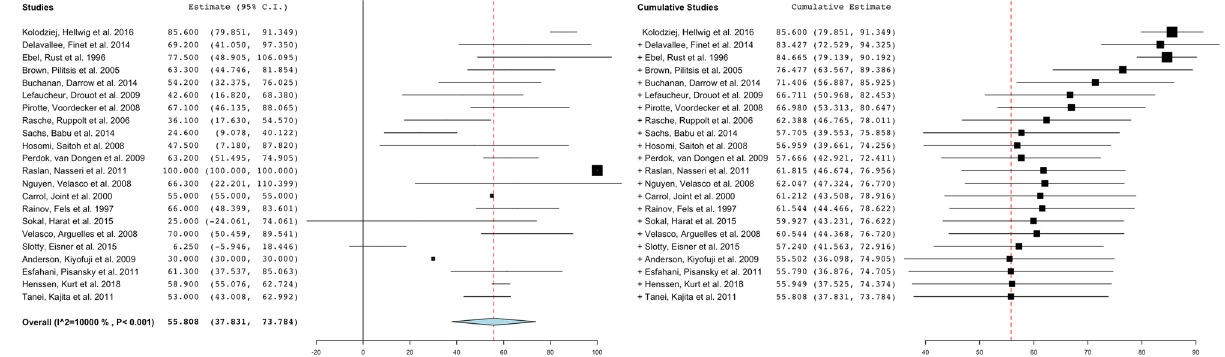
Figure 2. Forest-plot of pain relief (%) per study, the overall pain-relief (%) and heterogeneity as assessed by I 2 . Note: the study of Meyerson, Lindblom et al . 1993 could not be included in the forest-plot as this paper does not provide mean pain relief (%) data.